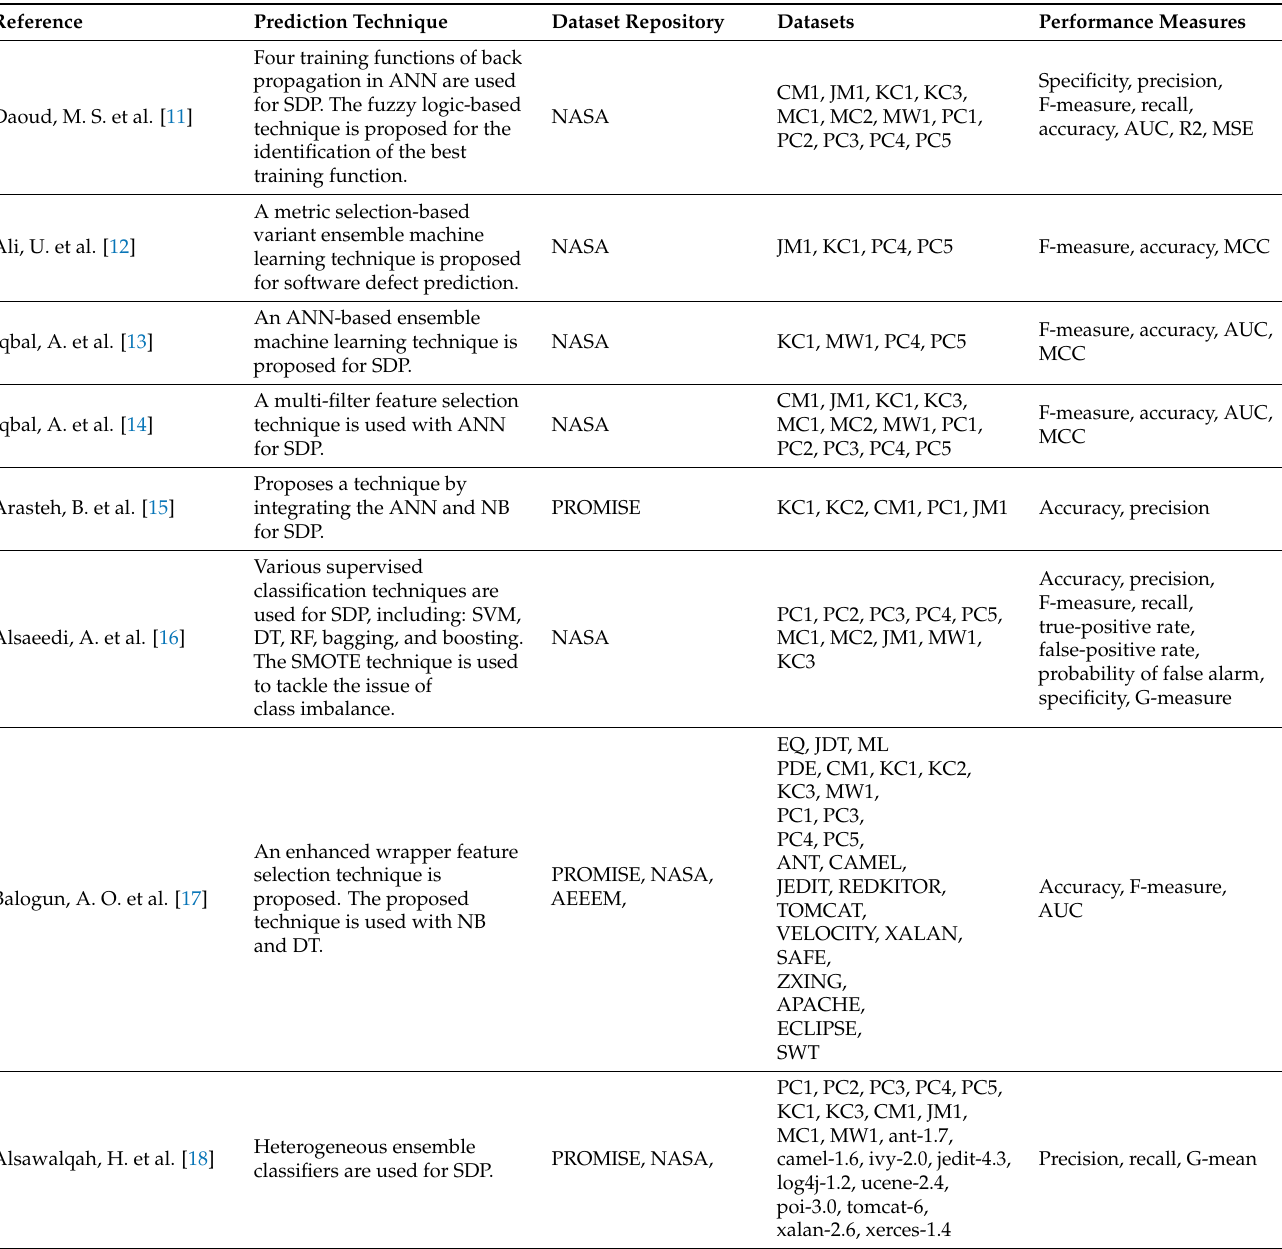
Table 1. Literature review